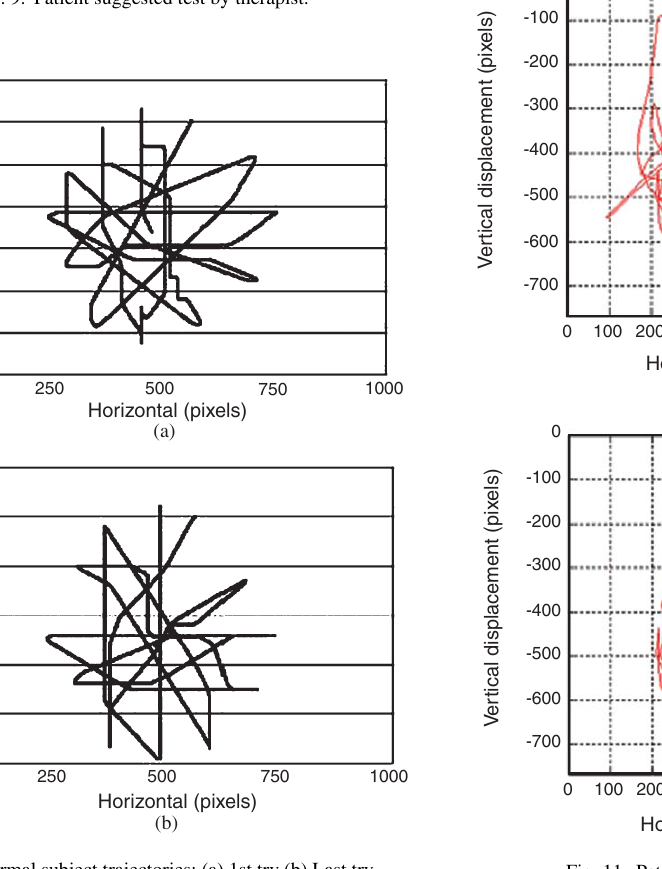
Fig. 9. Patient suggested test by therapist.